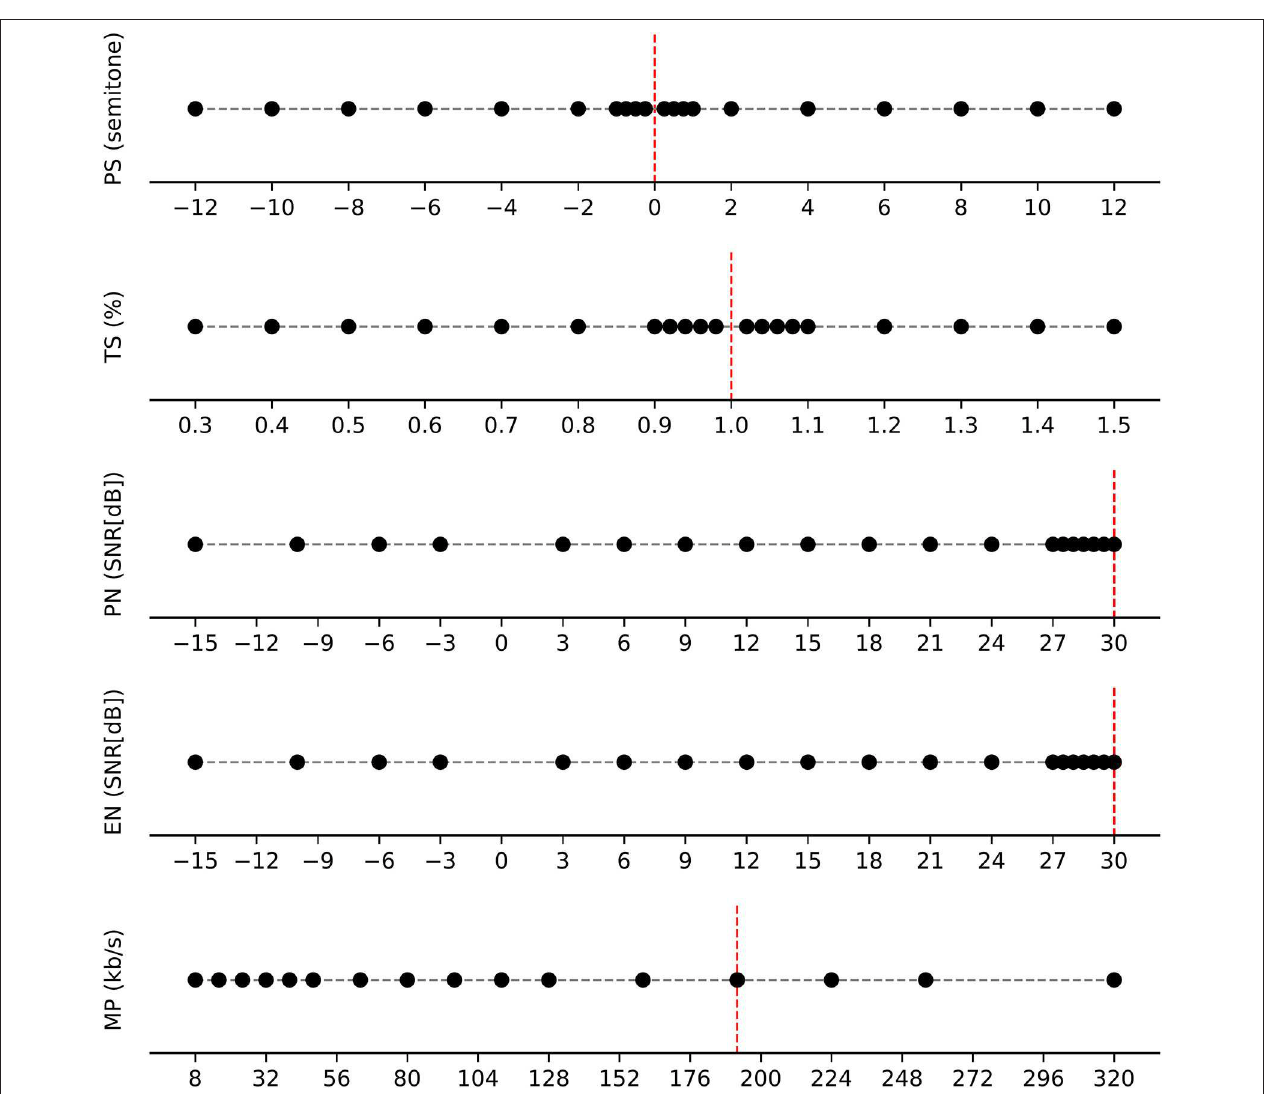
FIGURE 3 | The selected range of magnitudes with respect to the transformations. Each row indicates a transformation category; each dot represents the selected magnitudes. We selected relatively more points in the range in which transformations should have small effect, except for the case of MP3 compression. Here, we tested all the possible transformations (kb/s levels) as supported by the compression software we employed. The red vertical lines indicate the position of the original sample with respect to the transformation magnitudes. For TS and PS, these consider no transformation; for PN, EN and MP, they consider the transformation magnitude that will be closest to the original